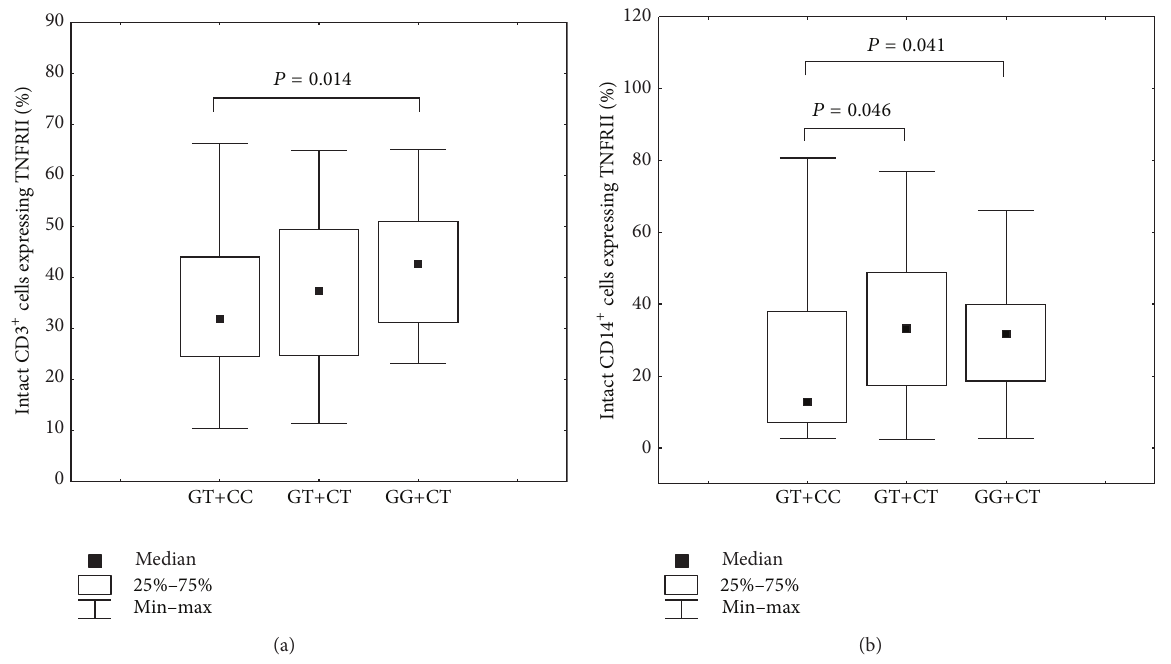
Figure 5: (a) Percentage of CD3 + cells expressing TNFRII in individuals presenting with different genotypes combinations of SNPs TNFRI − 609G/T (rs4149569) and TNFRII − 3609C/T (rs590368). Kruskal-Wallis 𝐻 test, 𝑃 = 0.048 , Mann-Whitney 𝑈 test: GT+CC versus GG+CT, 𝑃 = 0.01 . (b) Percentage of CD14 + cells expressing TNFRII in individuals with different genotypes combinations of SNPs TNFRI − 609G/T (rs4149569) and TNFRII − 3609C/T (rs590368). Mann-Whitney 𝑈 test: GT+CC versus GT+CT, 𝑃 = 0.046 , GT+CC versus GG+CT, 𝑃 = 0.04